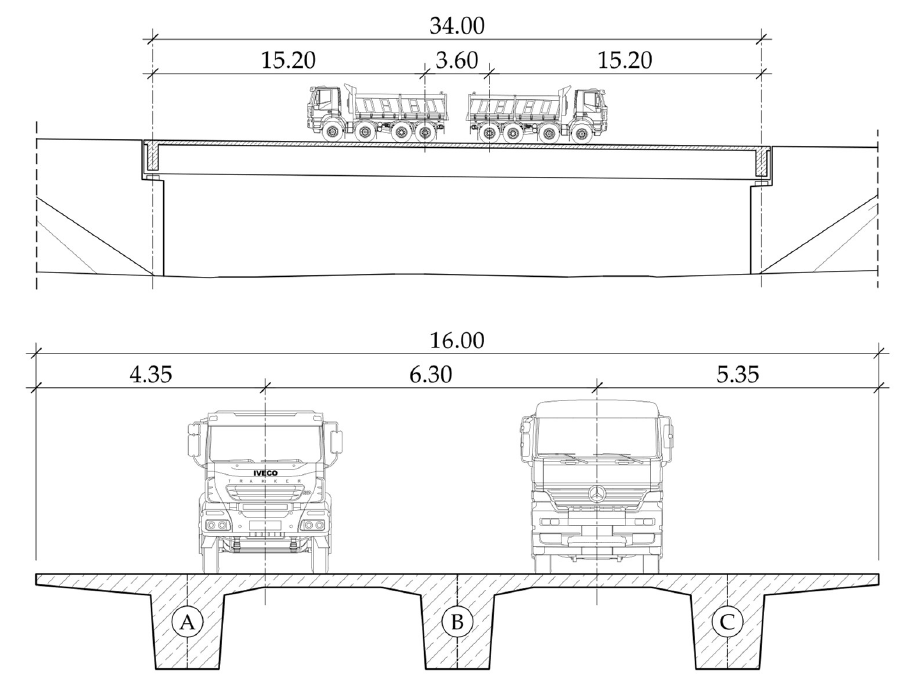
Figure 9. Truck location on the superstructure.